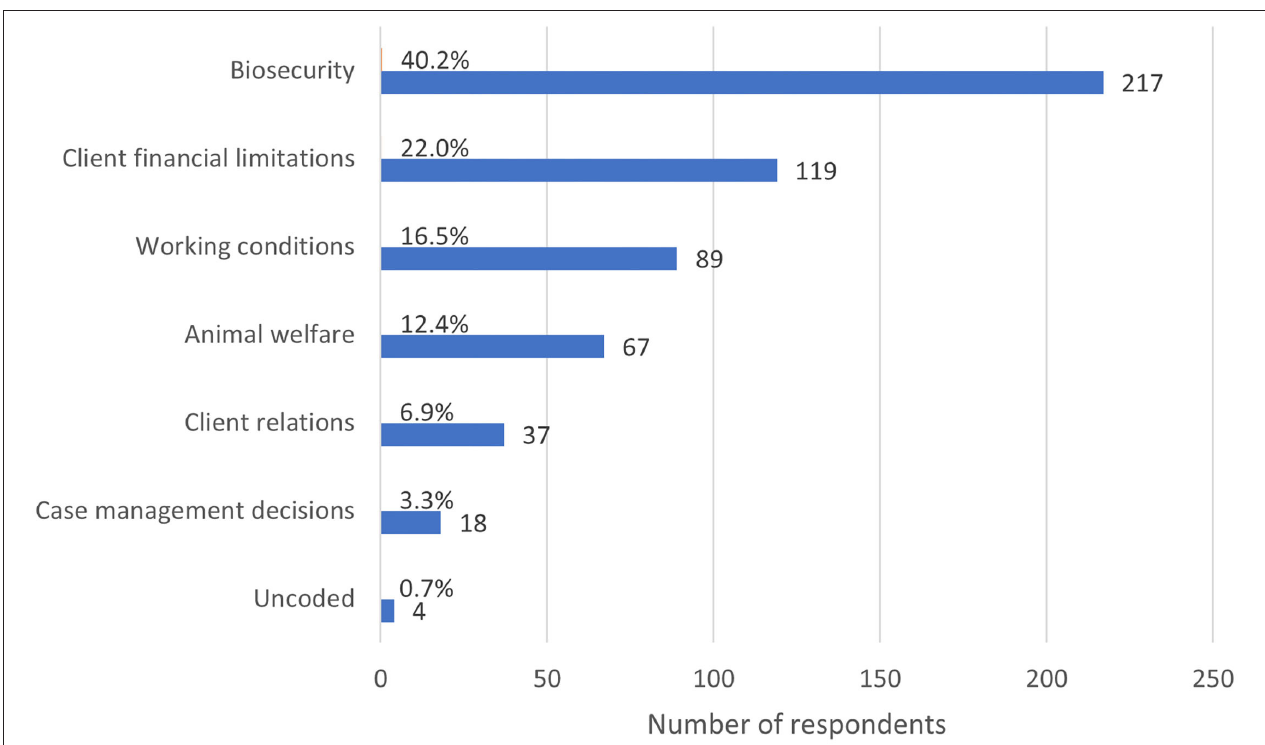
FIGURE 9 | Bar chart of the frequency of major themes from respondent descriptions of the most stressful ethically challenging situations encountered since the advent of the COVID-19 global pandemic, based on the responses of 540 veterinarians, animal health technicians and veterinary nurses, surveyed between May and July in 2020. Note that a single response could be coded for multiple